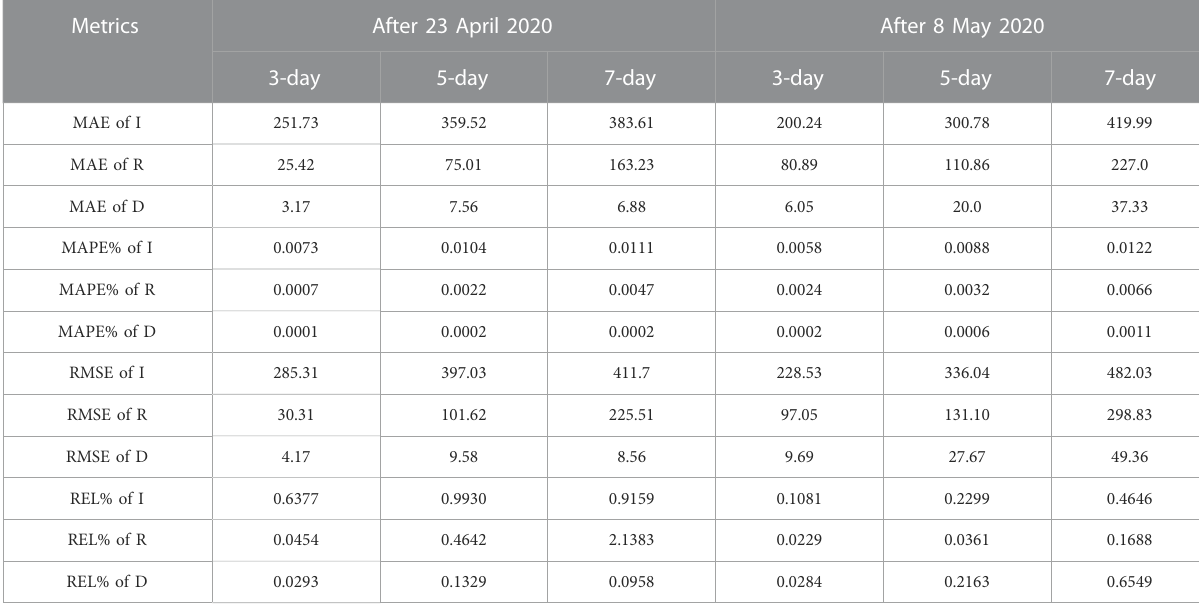
TABLE 1 The prediction performance in 3-day, 5-day and 7-day.